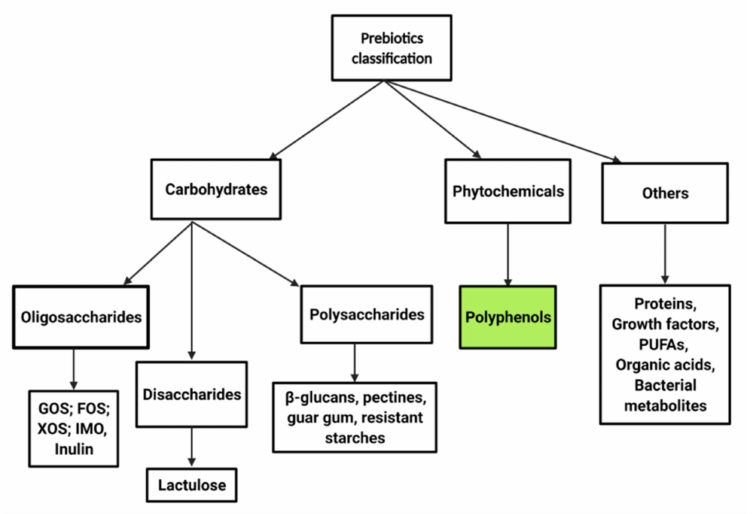
Figure 1. Prebiotic classification (GOS, galactooligosaccharides; FOS, fructooligosaccharides; XOS, xylooligosaccharides, IMO, isomaltooligosaccharides; PUFAs, polyunsaturated fatty acids) [38].